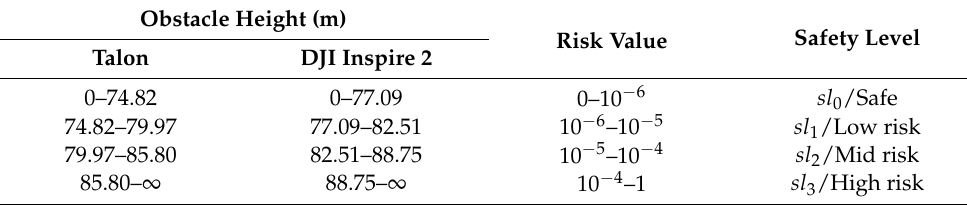
Table 6. Obstacle height classification for Talon and DJI Inspire 2.